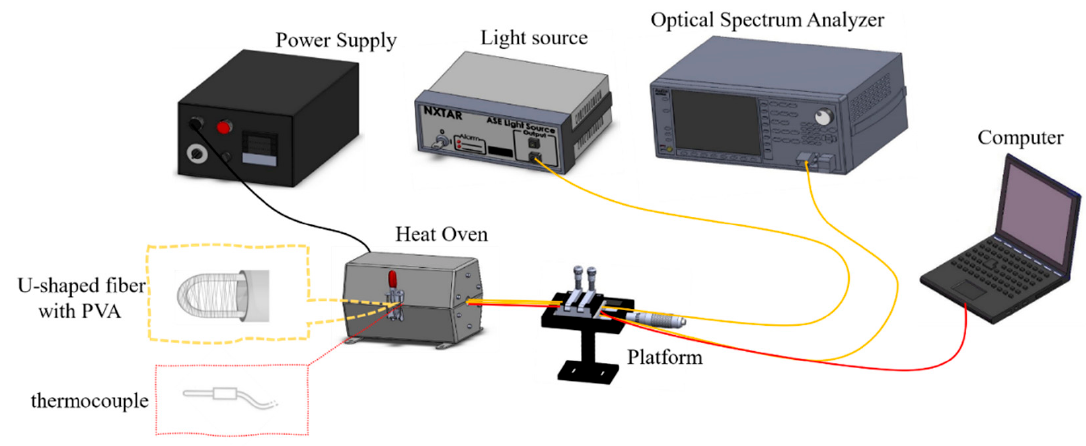
Figure 4. Setup for the temperature experiments. The electrospun PVA-coated sensor of the U-